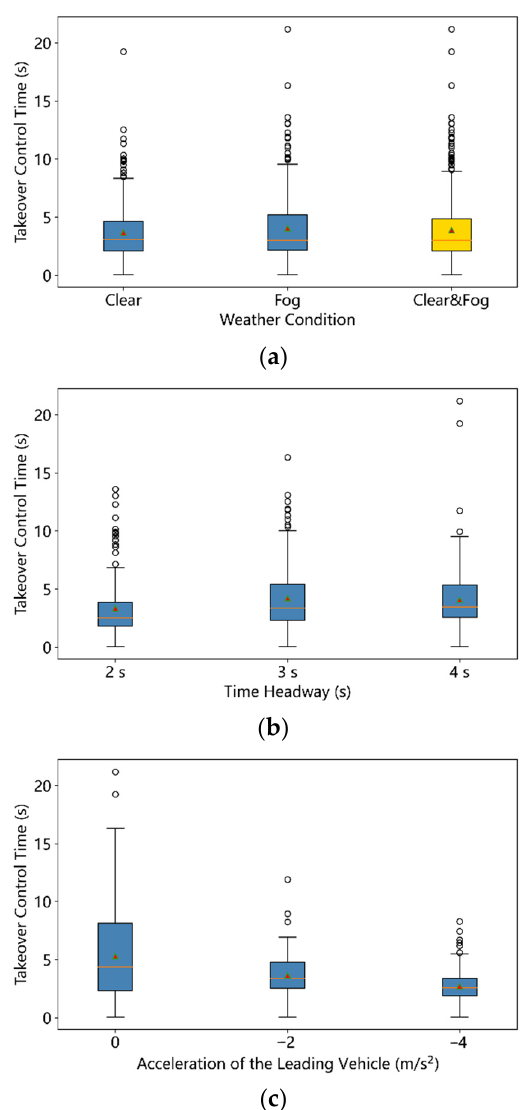
Figure 6. Boxplot of takeover control time of all 540 samples: ( a ) Weather Condition, ( b ) Time Headway, ( c ) Acceleration of the Leading Vehicle (the red triangle symbol denotes the mean value).